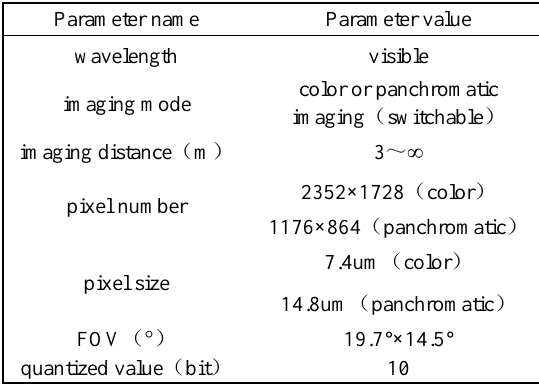
Table 1. Panoramic camera